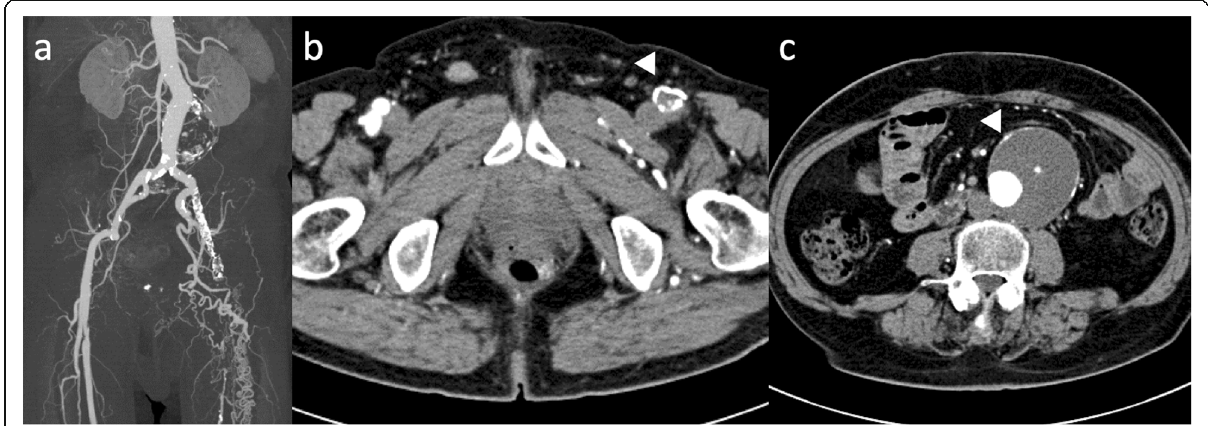
Fig. 1 CT before endovascular aneurysm repair. a : MIP image of CT angiography shows the occlusion of left EIA to SFA with abundant collateral channels from left hypogastric artery, b : transaxial image shows the occluded CFA with circumferential vessel wall calcification (arrow head), c : abdominal aortic aneurysm with the diameter of 55 mm (arrow head). CFA: common femoral artery, EIA: external iliac artery, MIP: maximum intensity projection, SFA: superficial femoral